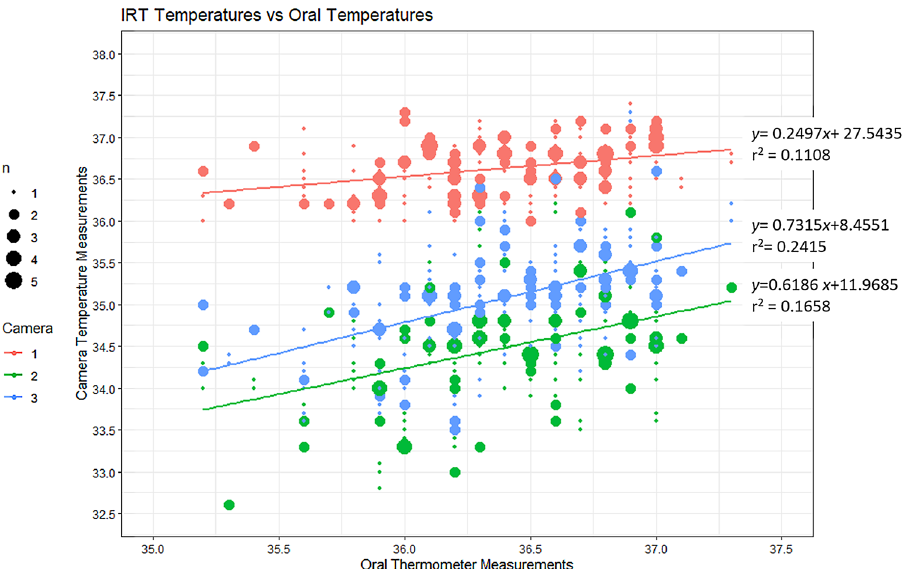
Figure 3. Bubble-plot of the IRT measurements vs the oral thermometer measurements.